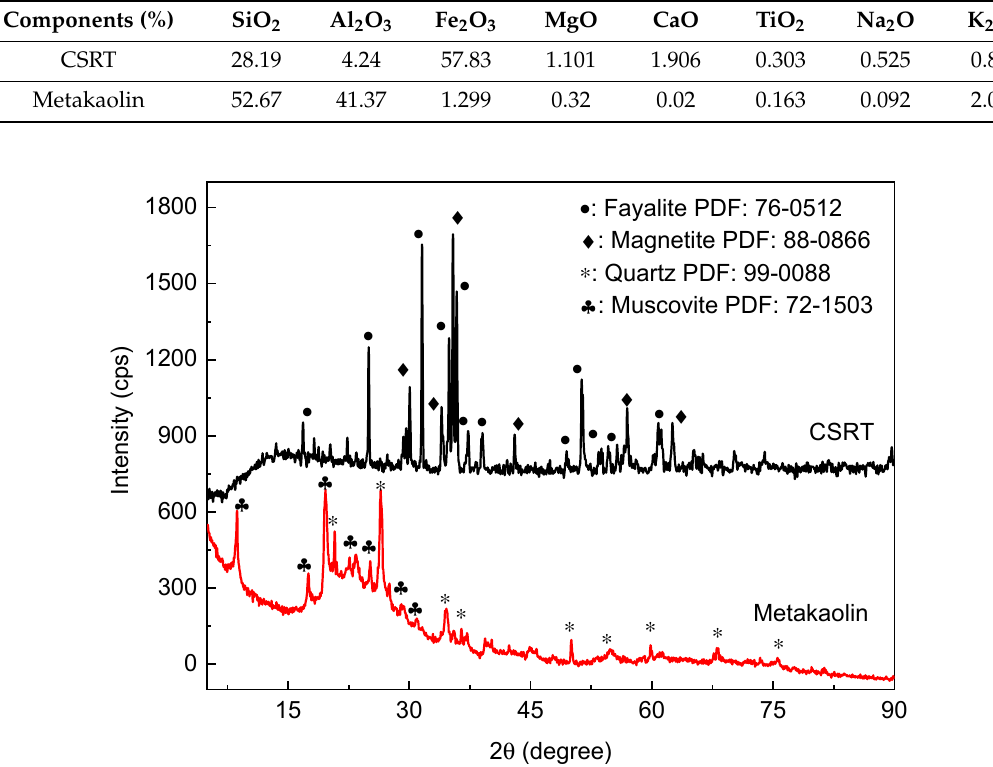
Figure 2. XRD patterns of the CSRT and metakaolin. Table 1. Chemical composition of the, copper slag reprocessing tailings (CSRT) and metakaolin. Components (%)